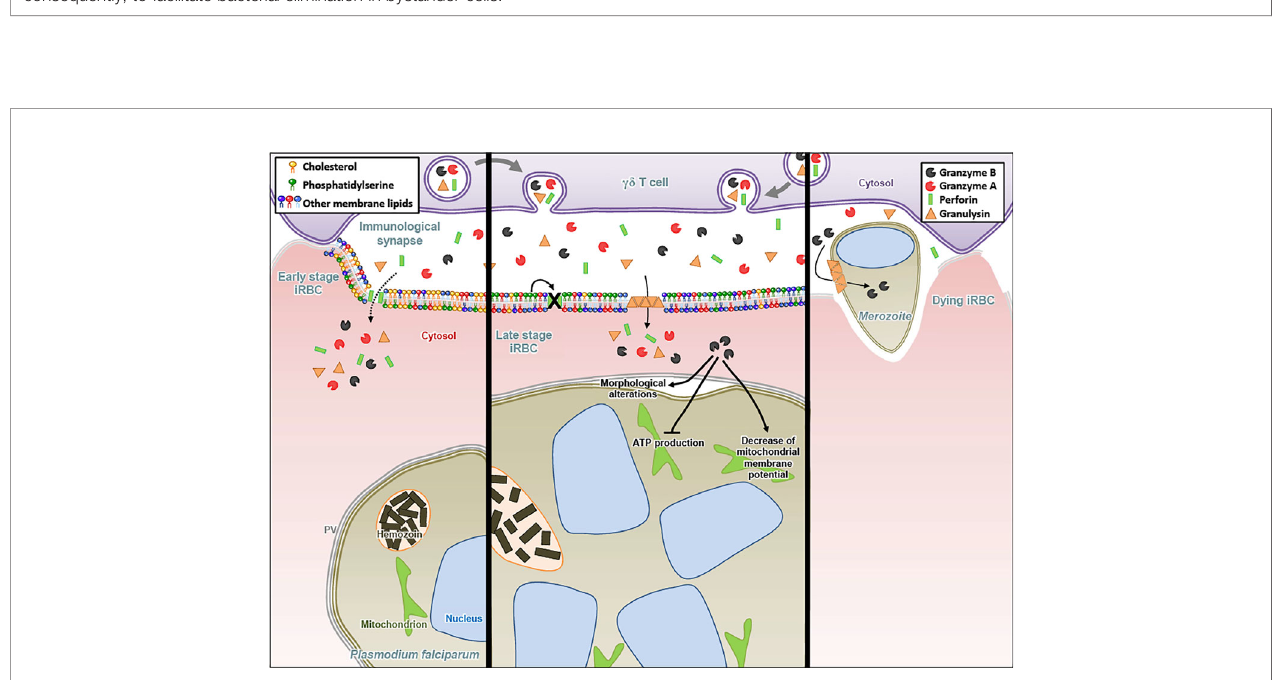
FIGURE 3 | Granzyme B released by gd T cells contributes to anti-malaria defense. The particular killer lymphocyte subset bearing the gd T receptor forms an immunological synapse with Plasmodium falciparum -infected red blood cells (iRBC). In early stage iRBC, the plasma membrane contains cholesterol-enriched lipid rafts and the negatively charged phosphatidylserine (PS) is predominantly present in the inner lea fl et. At that early stage, PFN can form membrane pores allowing the entry of Gzms, while being resistant to GNLY lysis. For late stage iRBC, cholesterol depletion allows the GNLY to disrupt the membrane while the surface exposure of PS inhibits the formation of PFN pores. Once in the iRBC, GzmB induces dramatic morphological alterations of late stage parasites (schizonts), notably the detachment of the parasitophorous vacuole (PV). Moreover, GzmB inhibits ATP production and decreases the mitochondrial membrane potential of the parasite. At the end of the parasite growth cycle, the rupture of iRBC plasma membrane leads to merozoites egress. GNLY also disrupts the membrane of the merozoite, allowing the entry of GzmB in the